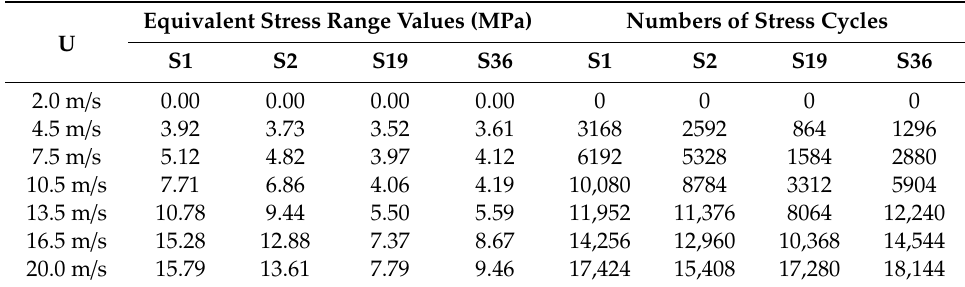
Table 6. Stress ranges and number of stress cycles due to wind load in one day.